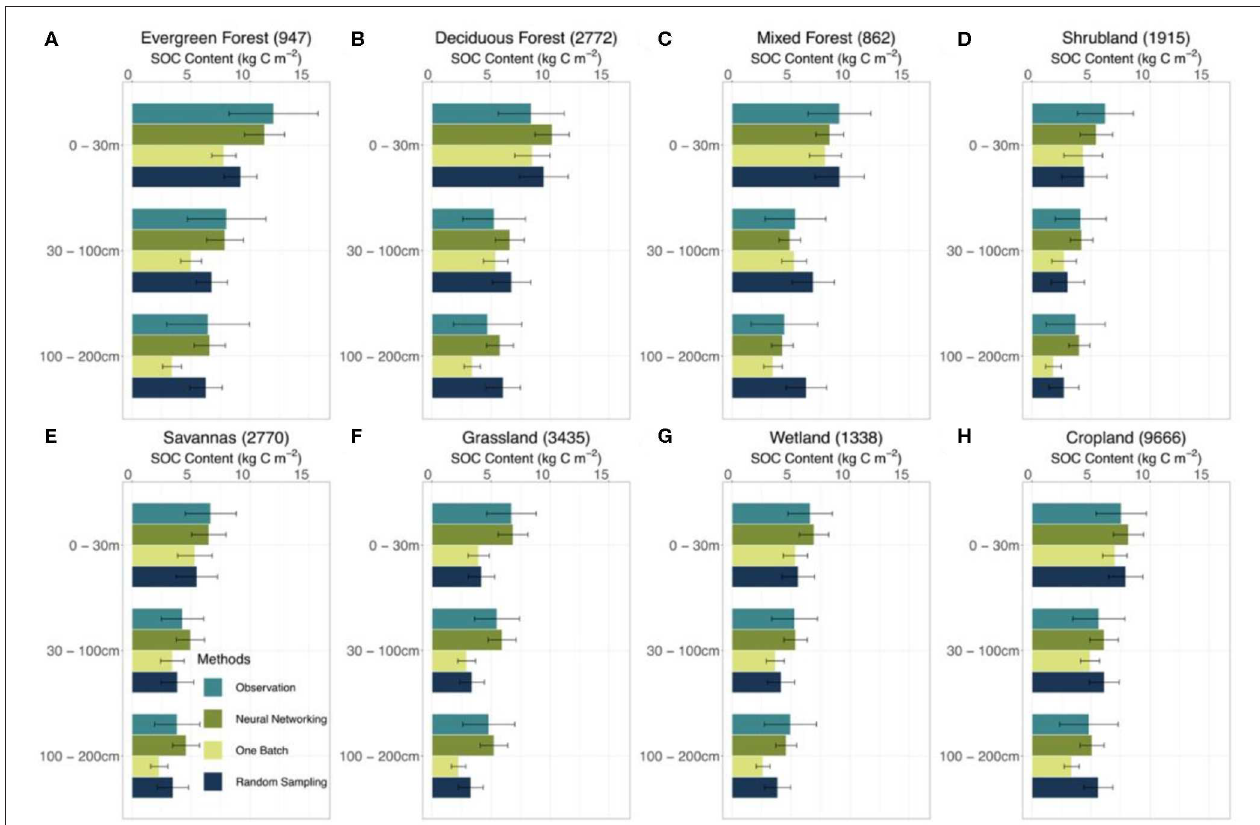
FIGURE 5 | Estimated SOC content in different vegetation types by different methods. Model performance at 0–30, 30–100, 100–200cm depth intervals by different methods (i.e., neural networking, one-batch, and random-sampling methods) was presented. The observation bars were plotted from the results of the site-by-site method considering its very good linear agreement between observed and modeled SOC content. The number in the parentheses after the names of vegetation types suggests the number of sites at corresponding vegetation type in the dataset we used in this study. The error bars indicate the ± 0.5 standard deviation. The distribution of different vegetation types on the conterminous United States is shown in Figure S7